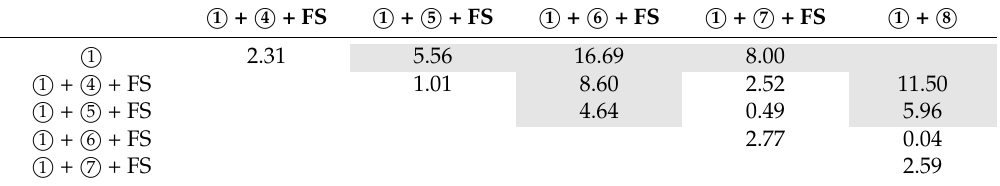
Table 13. The chi-square values of McNemar tests for land cover classification in complex surface-mined landscapes using the superior models that involved the addition of some types of feature sets to spectral bands combined with feature selection: 1 (cid:13) : spectral bands; 4 (cid:13) : the Gaussian low-pass filters; 5 (cid:13) : the mean filters; 6 (cid:13) : the standard deviation filters; and 7 (cid:13) : texture measures. FS80: feature selection with a threshold of 16. FS60: feature selection with a threshold of 12. The shaded ones that larger than 3.84 indicated statistically significant differences at the confidence level of 95% ( p < 0.05).